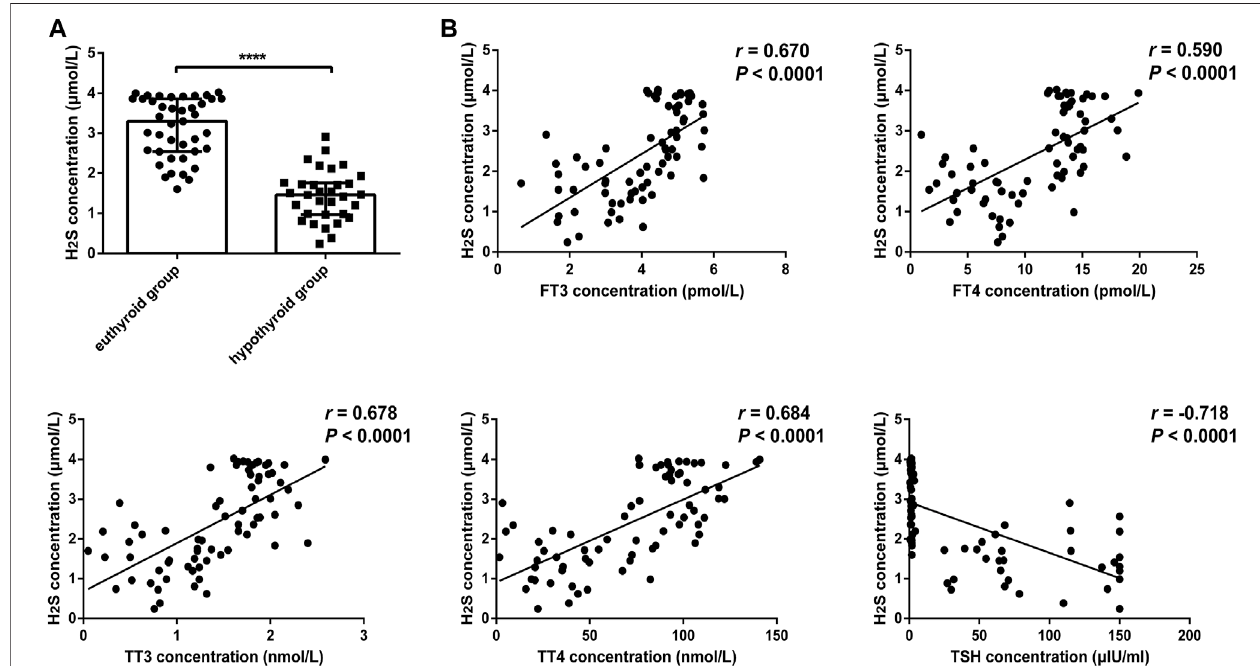
FIGURE 2| Comparison ofH 2 S levels in serum from euthyroid and hypothyroid groups in human and the relationship between H 2 S levels and thyroid function. (A) H 2 S levels in serum from the euthyroid ( n = 41) and hypothyroid ( n = 32) groups were analyzed by H 2 S -selective sensors. The H 2 S level was signi fi cantly lower in the hypothyroid group. (B) Correlations between H 2 S levels and thyroid function in serum samples. H 2 S levels were positively correlated with FT3, FT4, TT3, and TT4 levels and negatively correlated with TSH levels. A bivariate correlation analysis was performed by using Spearman rank test. r represents correlation coef fi cient. **** p < .0001. Data in Figure 2A are expressed as the median and interquartile range. H 2 S, hydrogen sul fi de; FT3, free triiodothyronine; FT4, free triiodothyronine; TT3, total triiodothyronine; TT4, total thyroxine; TSH, thyroid-stimulating